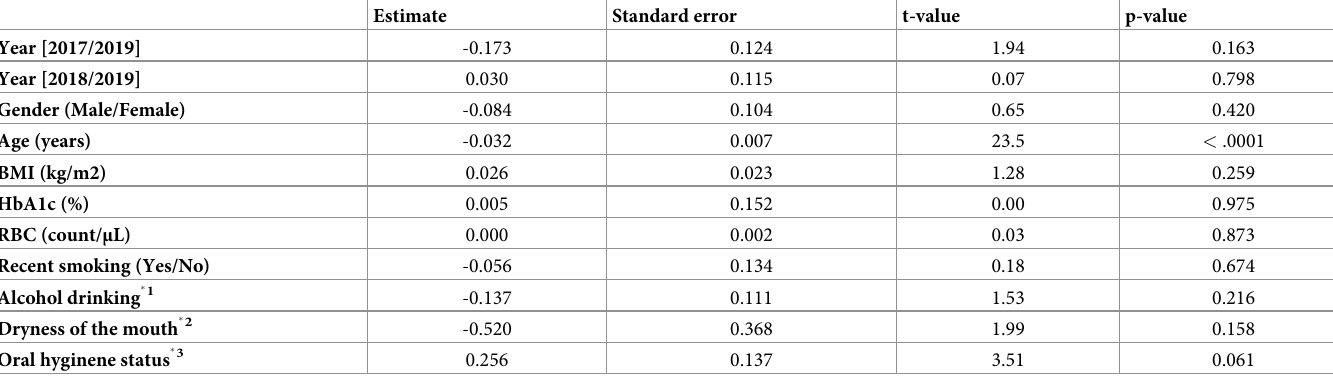
Table 3. Result of multivariate analysis assessing the correlation between influenza infection and oral